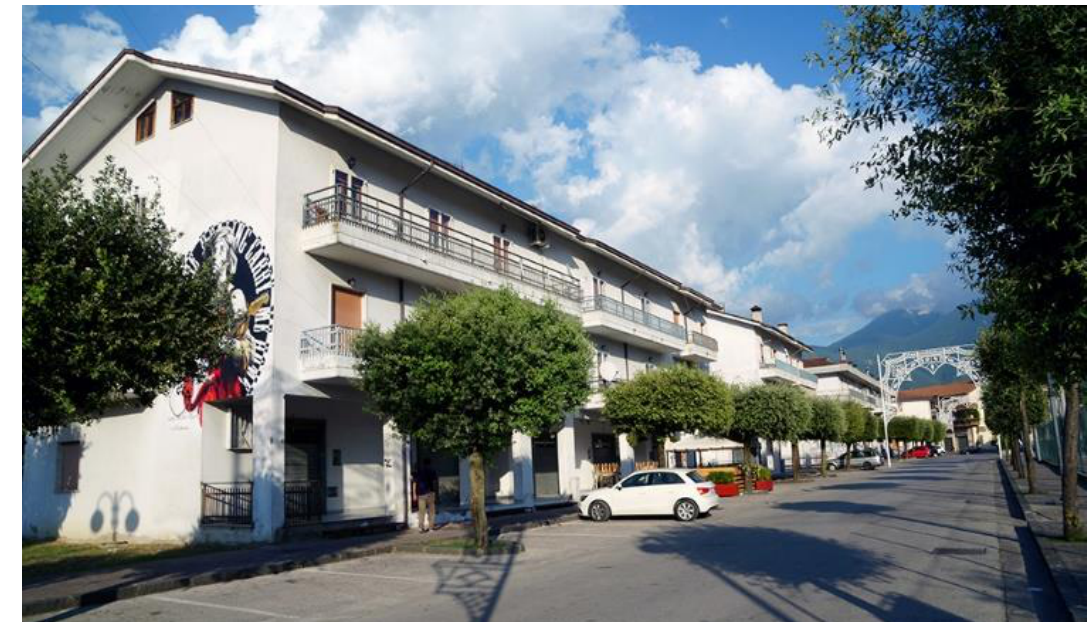
Figure 62. San Michele di Serino: new reinforced concrete buildings (photos by [35,36]).